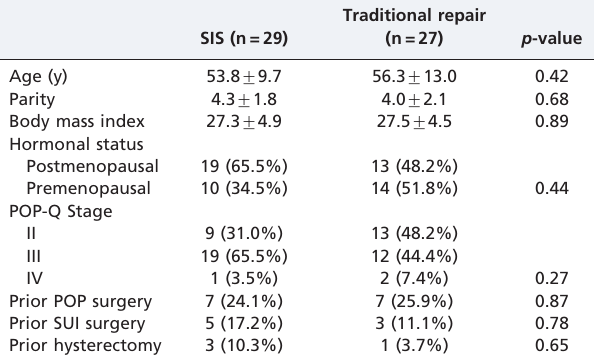
Table 1 - Baseline data. Values are presented as the means ( ¡ standard deviation) or the number of subjects